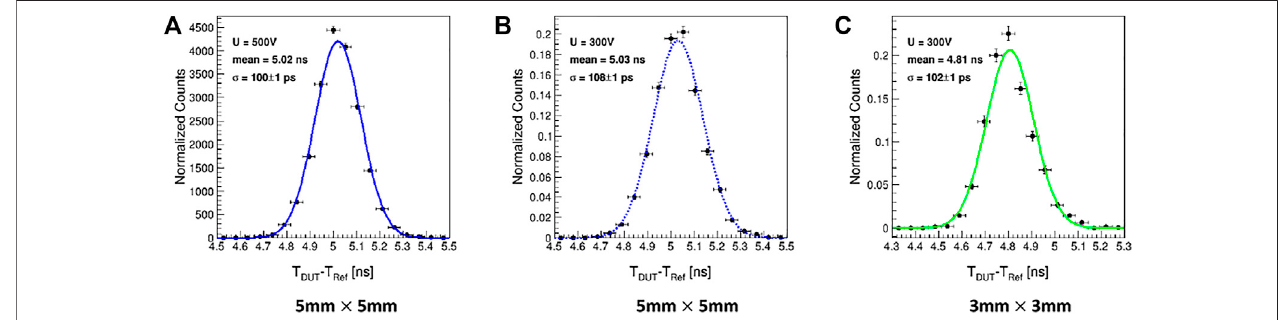
FIGURE 9| Δ T = T DUT − T Ref distributions after applying the CFD method with fraction = 0.5. (A) : 5 mm × 5 mm and U = 500 V , (B) : 5 mm × 5 mm and U = 300 V , and (C) : 1.5 mm × 1.5 mm and U = 300 V . The σ Δ T is extracted by Gaussian fi tting.